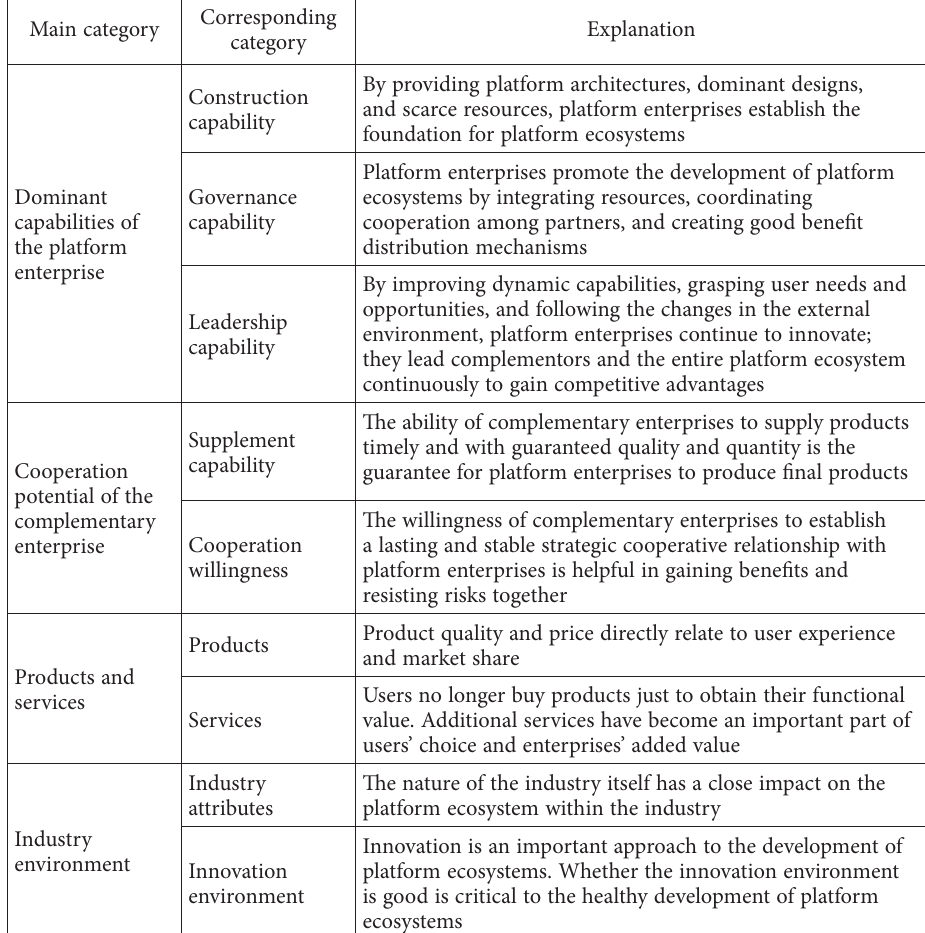
Table 4. Results of axial coding Main